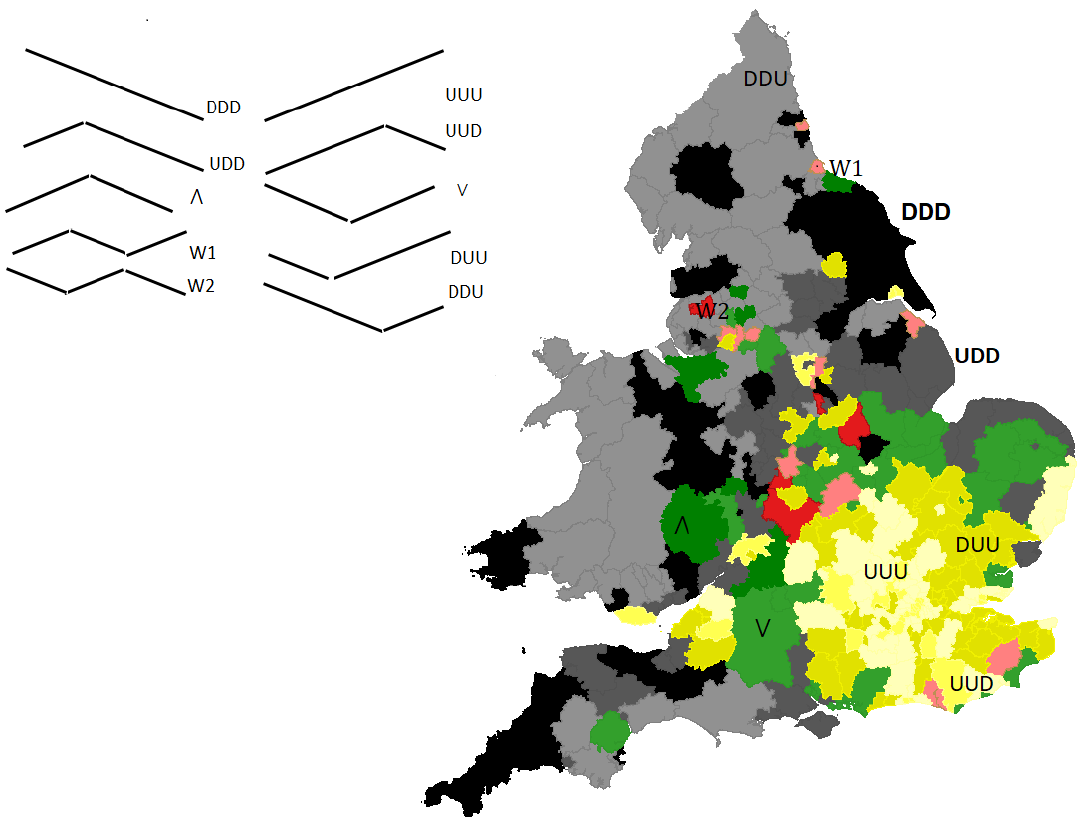
Figure 3. The Spatial Distribution of HPER Growth Trajectories. DDD = Continuous decline; ⋀ = Medium-term decline; UUD = Recent decline; DUU = Long-term resurgence; UDD = Long-term decline; W1, W2 = Growth set-back; ⋁ = Medium-term resurgence; DDU = Recent resurgence; UUU = Continuous growth.